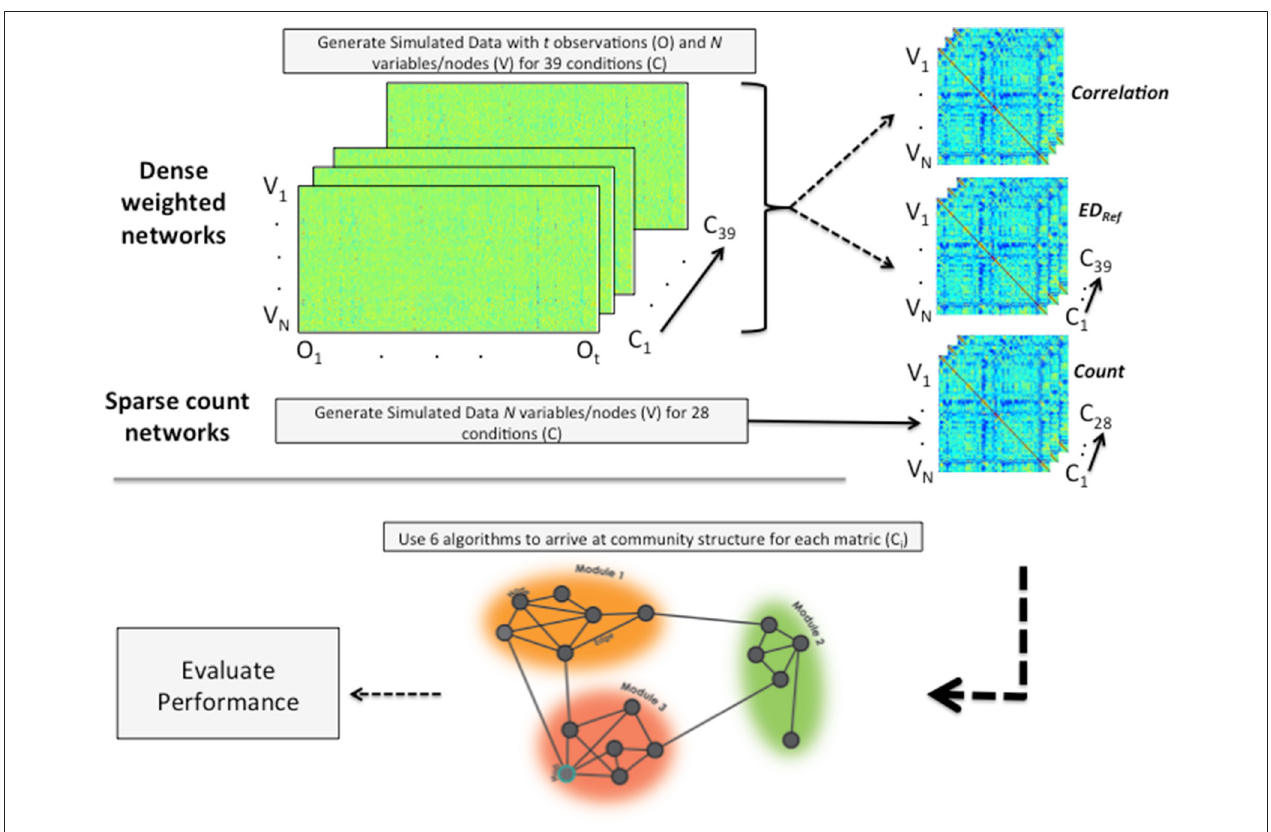
FIGURE 2 | Depiction of data simulation and analytic process. For dense weighted networks, time series data are generated. From these, correlation and (reflected) Euclidean distance matrices are computed. Sparse count matrices are made directly using the LFR benchmark simulation program. All data generated across all conditions are then subjected to each of the 6 community detection algorithms and their performance evaluated. “V” indicates variable or node; “O” indicates the observation, and “C” the